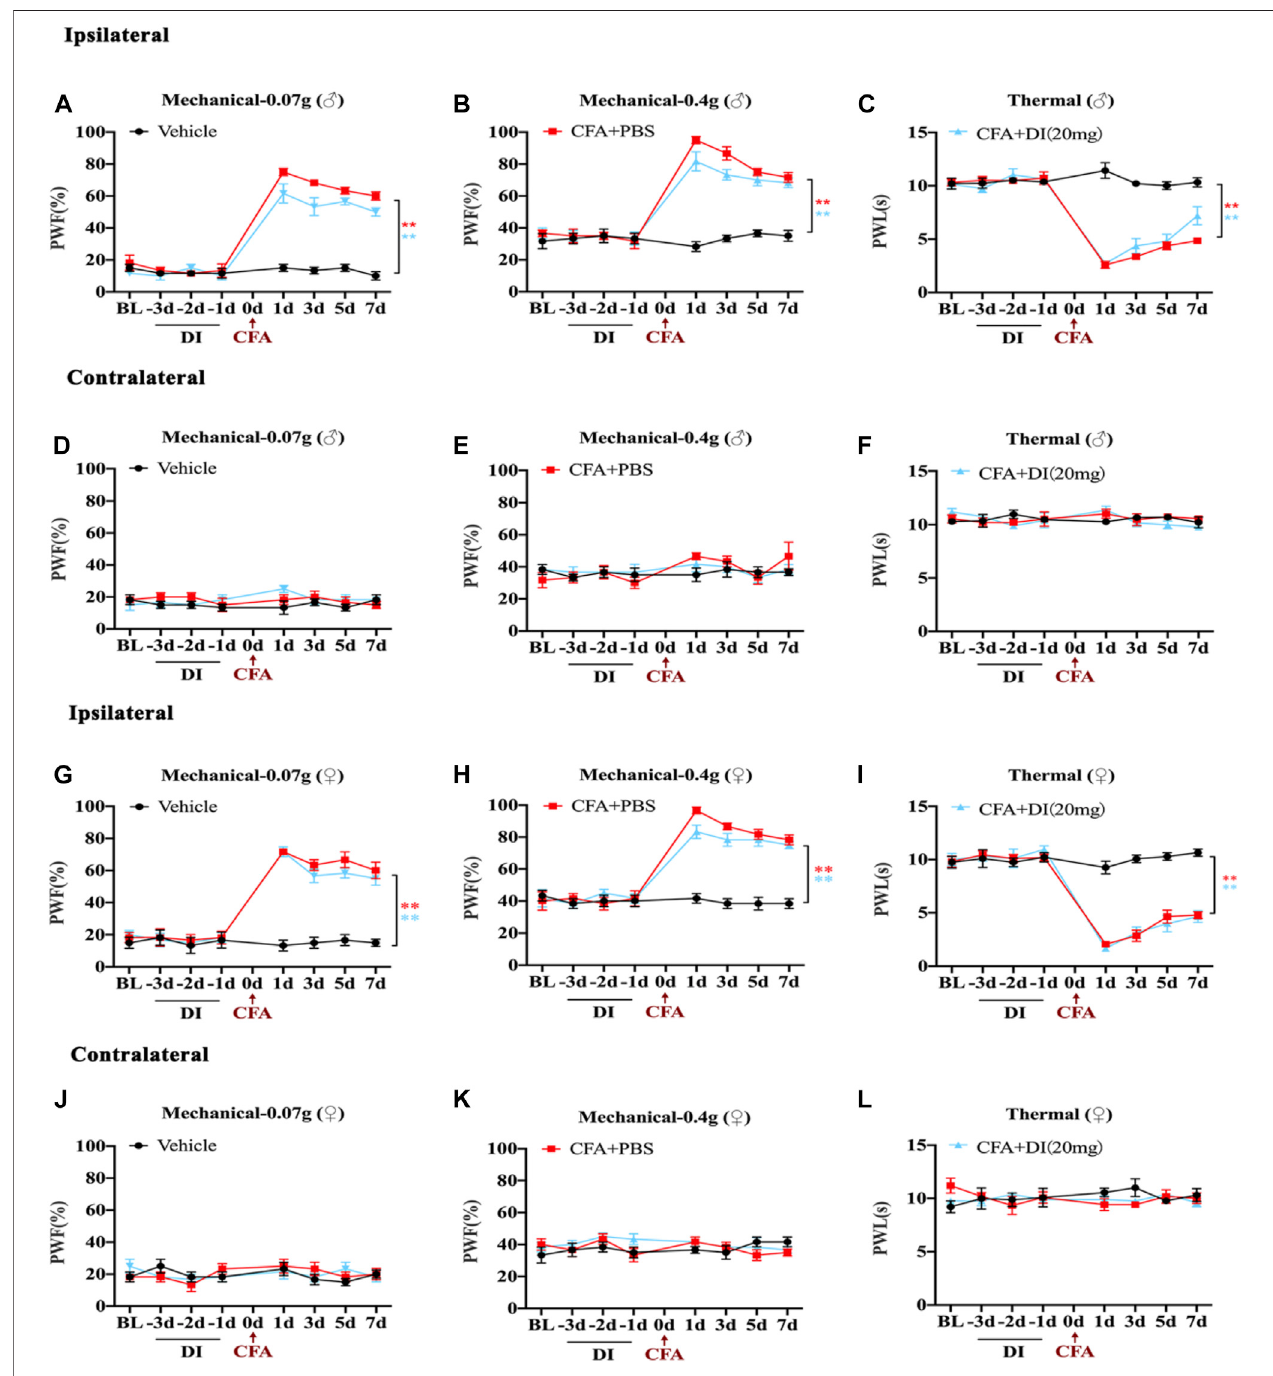
FIGURE2| EffectsofDIpretreatmentonCFA-inducedmicein fl ammatorypainmodel. (A,B) Theeffectonmechanicalallodynia(0.07or0.4 g)oftheipsilateralhind paw in male mice. F group (14, 80) = 26.60 for (A) , F group (14, 80) = 15.17 for (B) . (C) The effect on thermal hyperalgesia ipsilateral hind paw in male mice. F group (14, 80) = 24.28 for (C) . (D – F) The effect of mechanical allodynia and hyperalgesia of the contralateral hind paw. F group (14, 80) = 0.8967 for (D) , F group (14, 80) = 0.8594 for (E) , F group (14,80)=1.560for (F) . (G,H) Theeffectonmechanicalallodynia(0.07or0.4 g)oftheipsilateralhindpawinfemalemice.F group (14,80)=16.72for (G) ,F group (14, 80) = 12.55 for (H) . (I) The effect on thermal hyperalgesia ipsilateral hind paw in female mice. F group (14, 80) = 17.73 for (I) . (J – L) The effect of mechanical allodynia andhyperalgesiaofthecontralateralhindpaw.F group (14,80)=0.9991for (J) ,F group (14,80)=1.161for (K) ,F group (14,80)=1.198for (L) .Datavaluesareexpressedas mean ± SEM. N = 6 mice/group. ** p < 0.01 versus the vehicle group.